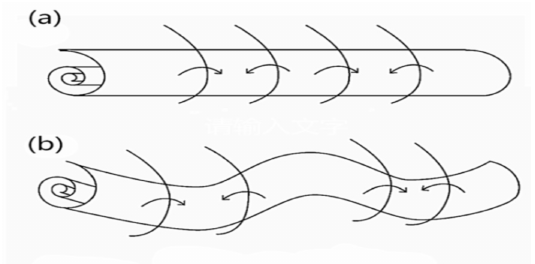
Figure 12. Schematic of the separated spanwise roll wrapped with the rib structure. ( a ) spanwise roll with the rib structure occurring at the upper edge of the back window; ( b ) spanwise roll with the rib structure occurring on the lower edge of the model rear.